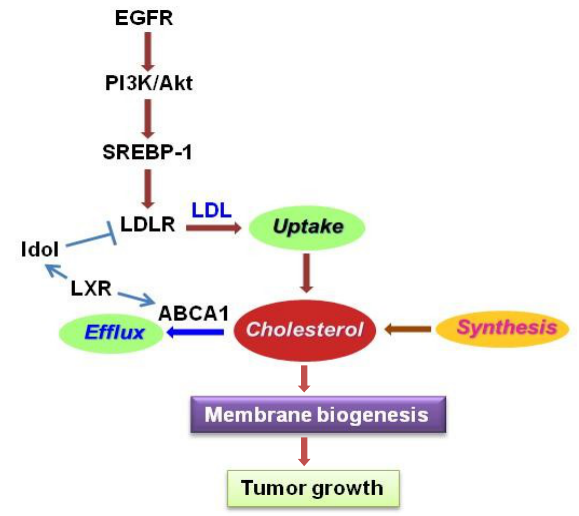
Figure 3. Regulation of cholesterol metabolism in gliomas. Cholesterol homeostasis is regulated by uptake, synthesis and efflux. EGFR/PI3K/Akt signaling upregulates LDLR expression mediated by SREBP-1 to promote cholesterol uptake. Activation of LXR stimulates ABCA1 expression and promotes cholesterol efflux, but also reduces LDLR levels via upregulation of Inducible Degrader of LDLR (Idol), a ubiquitin ligase E3. LXR, liver X receptor; ABCA1, ATP-binding cassette transporter member 1; LDL, low density lipoprotein; LDLR, LDL